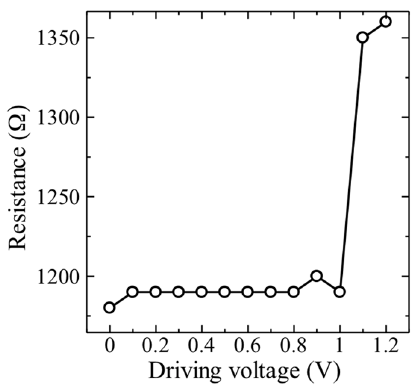
Figure 8. Spin-transfer switching (STS) characteristics of the LM element in the 2 µm pixel pitch spin-SLM. (bias magnetic field: − 35 Oe).